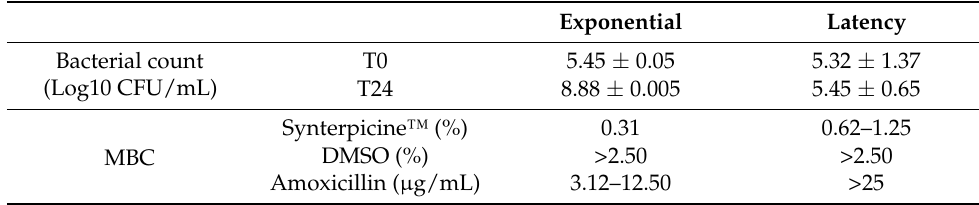
Table 6. MBC of Synterpicine™ on latent and exponentially growing Escherichia coli . Concentrations ranged from 0.048 to 25 µ g/mL for amoxicillin, and from 0.0049% to 2.50% for Synterpicine™ and DMSO. Growth controls on exponential and latency/non-growing bacteria were performed at 0 (T0) and 24 h (T24). DMSO (carrier) and amoxicillin (antibiotic) were used as negative and positive controls, respectively ( n = 3). Exponential Latency